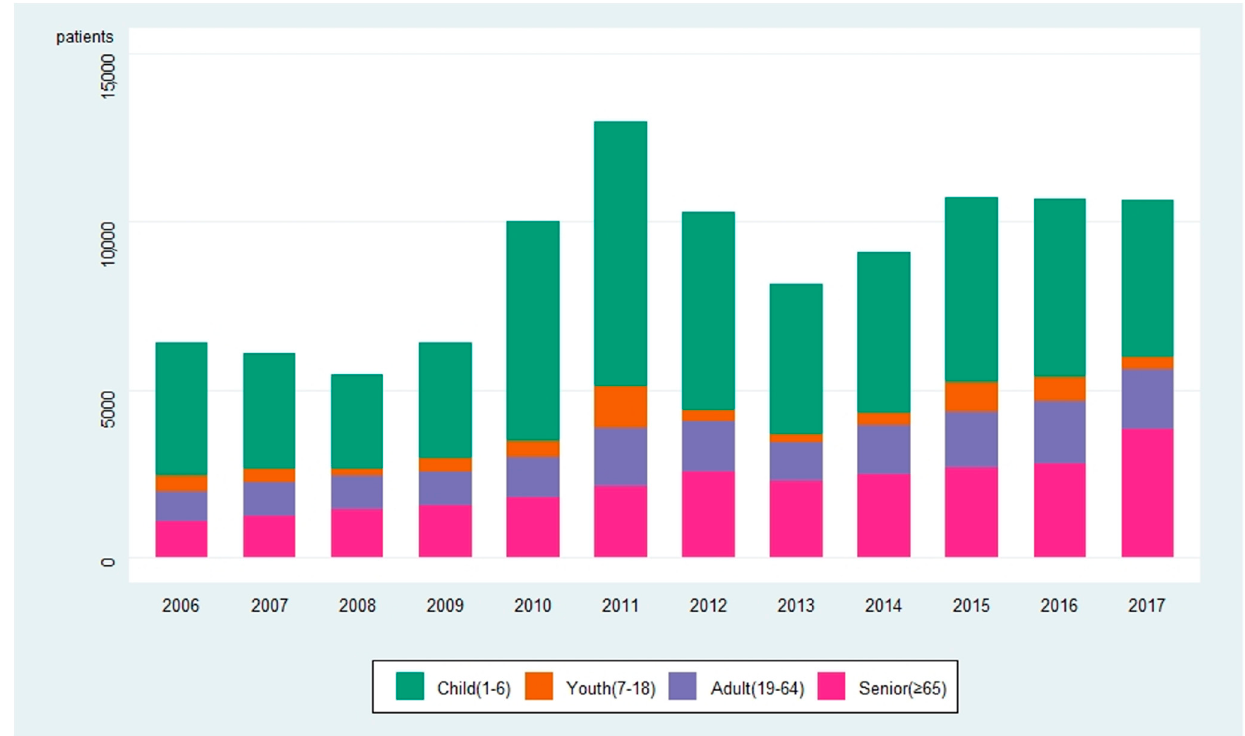
Figure 1. The number of discharged pneumonia patients in each year and age group (2006–2017). In terms of the weighted percentage of discharged pneumonia patients compared to the total number of discharged patients in South Korea each year, a decreasing trend was noted in children since 2011, but in seniors, this trend was increasing. The number of adolescents and adults fluctuated and showed a decreasing trend since 2015 (Figure 2).